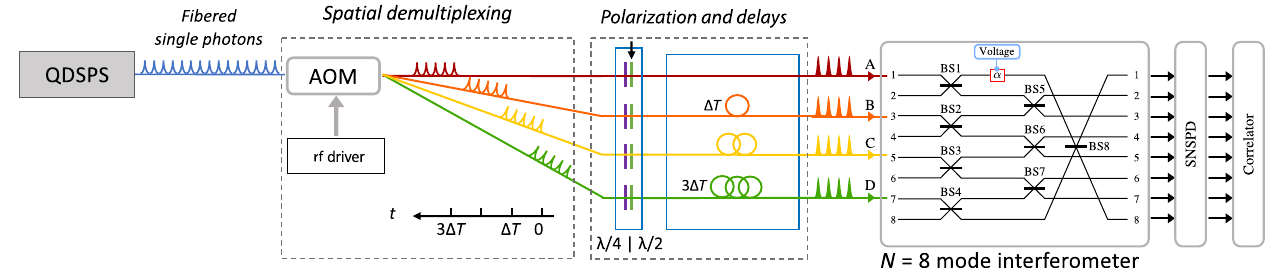
FIG. 2. Schematic of the experimental setup. A quantum-dot-based single-photon source (QDSPS) is excited periodically and emits a stream of single photons. The photons are separated into four spatial modes using a demultiplexer which is based on a periodically driven acousto-optic modulator (AOM). The polarization of the photons is controlled using wave plates, and delay fibers are used to ensure the simultaneous arrival times of the four photons. The photons are sent into the odd modes of the integrated CI, fabricated by femtosecond laser micromachining. The photons are detected at the output of the interferometer using superconducting nanowire single- photon detectors (SNSPDs), and four-photon coincidences are recorded using a correlator. The internal phase of the interferometer α 1 is varied by scanning the voltage applied to the microheater realized on the chip